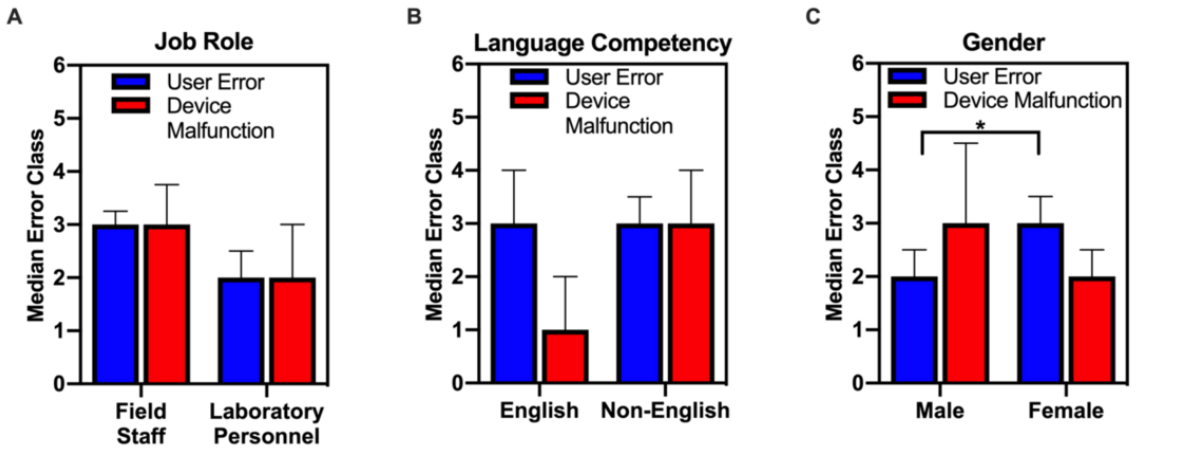
Figure 3. User errors and device malfunctions compared across demographics. Statistically significant (* P =.04) difference in median user errors between men and women. Errors bars represent semiinterquartile